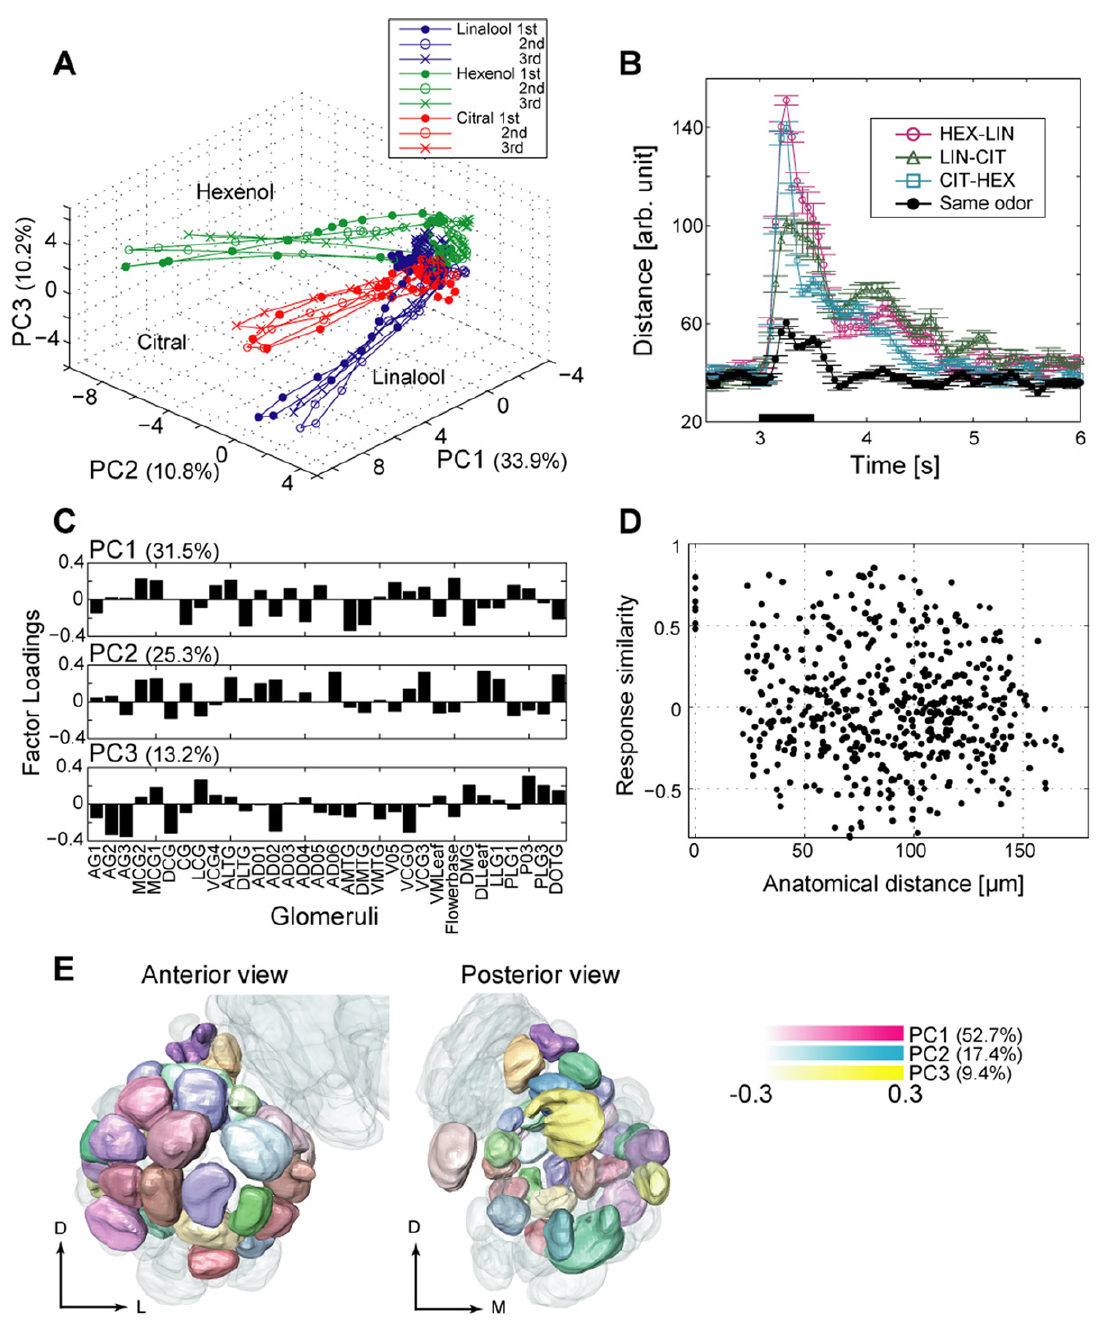
Figure 5 | Organization of evoked network activity in the AL . (A) Illustration of the trajectories representing PN population activity over time in response to cis -3-hexen-1-ol (green), linalool (blue), and citral (red). For each odor, 47 PN spike sequences were divided into consecutive 50-ms time bins and the number of spikes in each bin was counted. We viewed the 47-dimensional vector as odor representation by the PN population. To visualize the 47-dimensional vector, we applied principal component analysis (PCA) to the vector and used the fi rst three PCs for the graph. The variance captured by the fi rst three PCs was 54.0% of the total. Each representation evolved in an odor-specifi c manner. (B) Euclidean distance between odor representations as a function of time. We calculated the Euclidean distance between the 47-dimensional vectors used in (A) . Each trace showed similar profi les. The distances increased by about 100 ms after stimulus onset, peaking at 250–300 ms after stimulus onset (150–200 ms after response onset). At 550–750 ms, possibly in sustained stimulus presentation, the dis- tances began to stabilize. From about 1000 ms after stimulus onset, the distances remained stable and at higher levels than before stimulation. (C) Distribution of factor loadings for PCs 1–3. Glomeruli are ordered roughly from anterior to posterior (right to left in the graph). We applied PCA to the 32-dimensional vector as in (A) . The fi ring rates of PNs innervating the same glomerulus were averaged. (D) Response similarity as a function of anatomical distance between glomeruli. We used Pearson correlation coeffi cients of the responses of pairs of PNs to represent response similarity. Firing rates from the stimulus onset to 1 s after the stimulus onset (20 time bins) were used (the same value used in Figures 2D, 2E, and 3B ). Pairs of PNs innervating different glomeruli show no strong correla- tion ( r = –0.0556, n = 496). (E) Anterior and posterior views of the color map of the olfactory response profi le. First, we calculated correlation coeffi cients for all pairs of 32 glomeruli (32 × 32 matrix). To visualize the 32-dimensional vectors, PCA was used and vectors were embedded in the color space defi ned by the fi rst three PCs (magenta, blue, and yellow for PCs 1–3, respectively). Glomeruli were labeled by the color defi ned in the PC space. PCs 1–3 account for 79.5% of the total variance. Similarly colored glomeruli have similar response profi les; differently colored glomeruli have different response profi